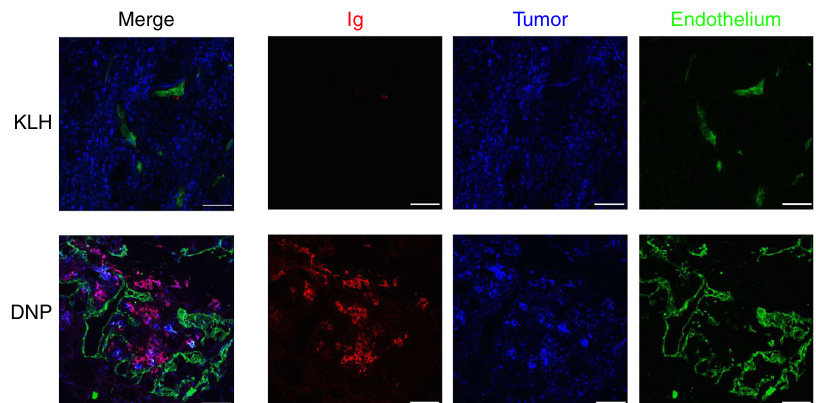
Fig. 3 Immunoglobulin deposit formation in the tumors of DNP, but not KLH, immunized mice treated with VEGF – DNP. Palpable 4T1 tumor-bearing mice prevaccinated against DNP or KLH were injected intravenously with VEGF aptamer – DNP conjugate and 24 h later tumors were excised. Immunohistochemistry was performed using antibodies against IgM/IgG (red), pan-endothelial marker (green), and wide spectrum cytokeratin staining mainly the 4T1 tumor cells (blue). Tissue sections were imaged using a Leica SP5 inverted confocal microscope with a PL APO CS ×20/0.70 objective as described. Scale bar = 50 μ m. ( n = 1)